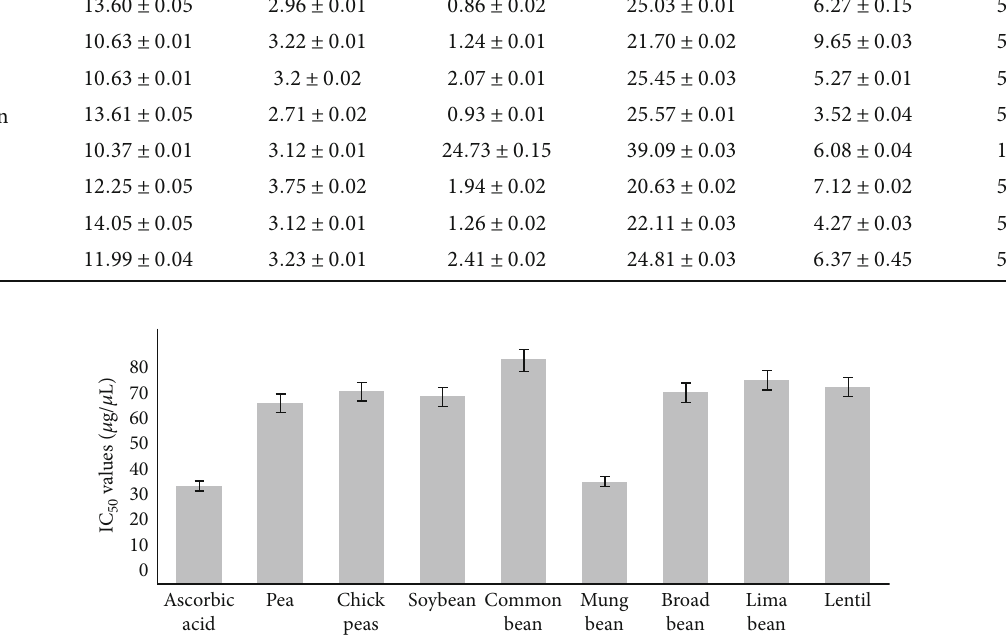
Table 2: The proximate composition analysis of eight legume grains per 100 g (%) of samples. Legume grains Moisture